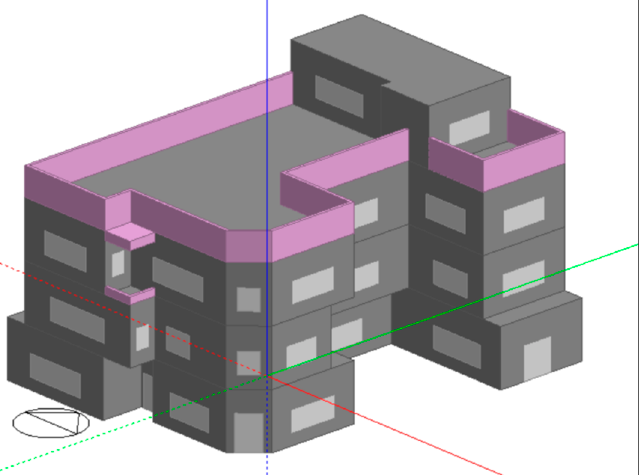
Figure 6. Screenshot of DesignBuilder software interface of a sample archetype model. Table 2. Average unit energy consumption of AC systems for different residential dwellings in Kuwait.